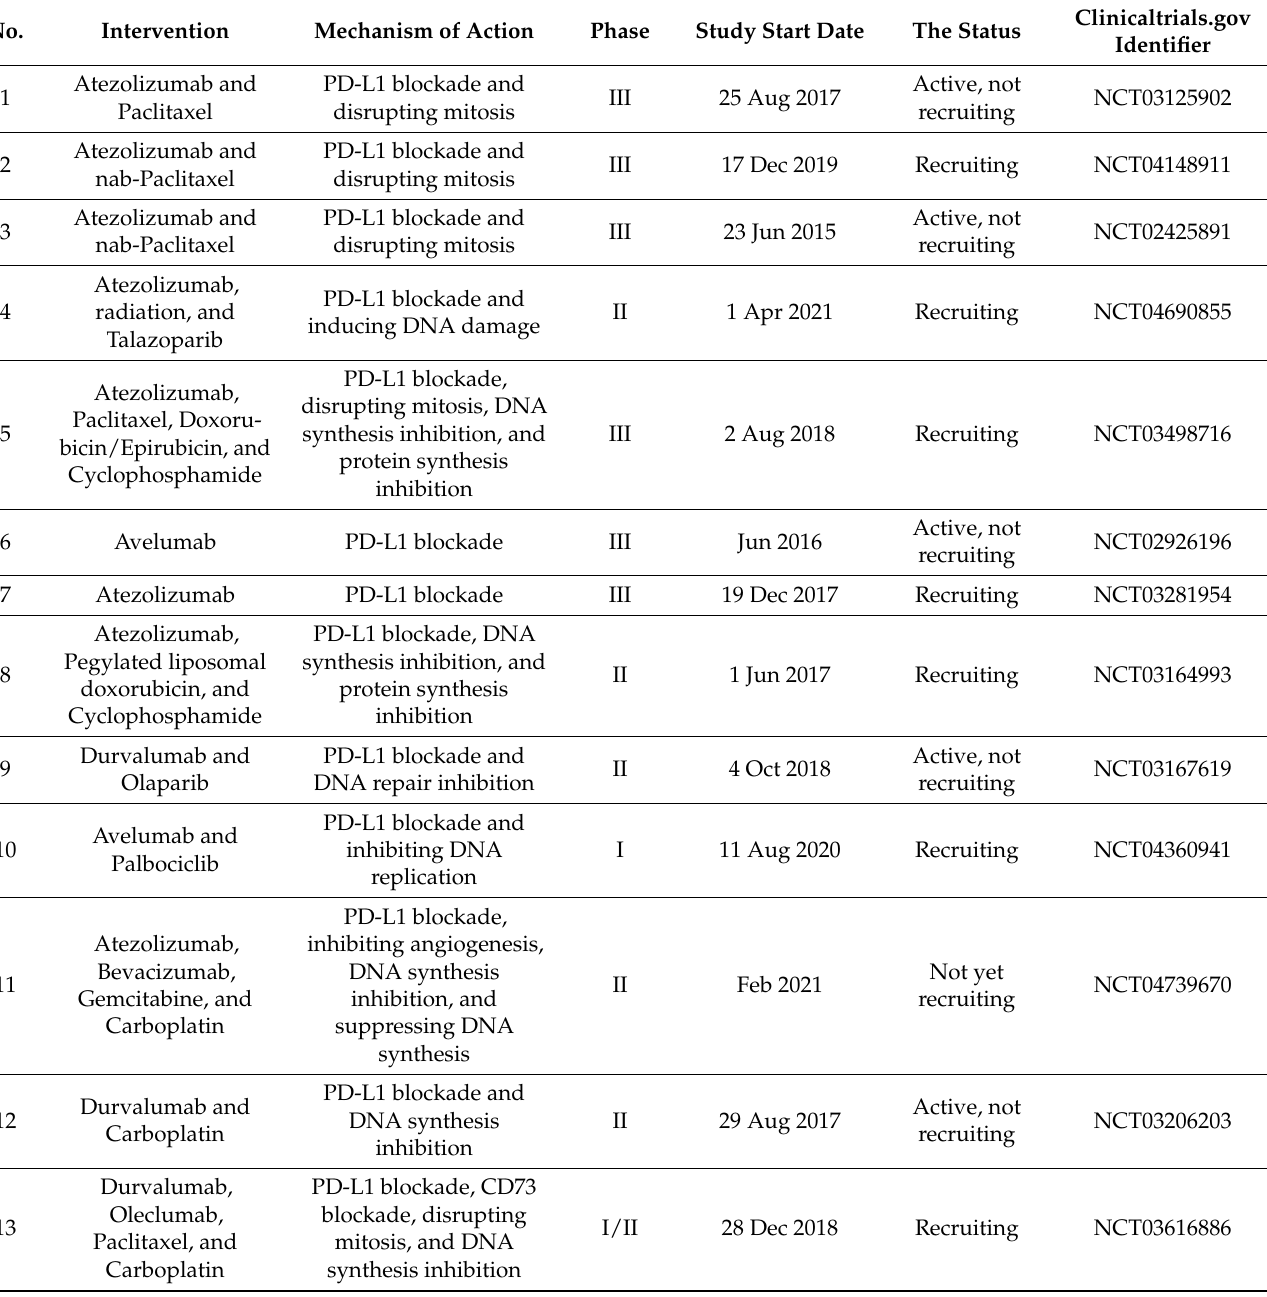
Table 5. The recent trend in the clinical trials for targeting PD-L1 for TNBC patients.